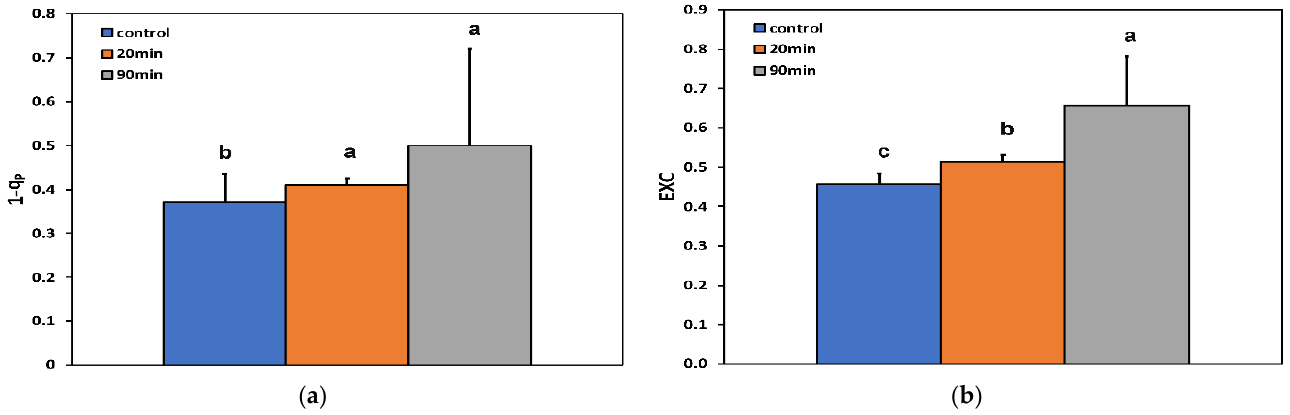
Figure 4. Changes in ( a ) the 1 − q p (data of Figure 3a) and ( b ) the EXC of potato leaves, at the whole leaf level, before (control) and after 20 and 90 min feeding by Halyomorpha halys . Error bars ± SD ( n = 5). In each parameter, the columns with different lowercase letters are statistically different ( p < 0.05).